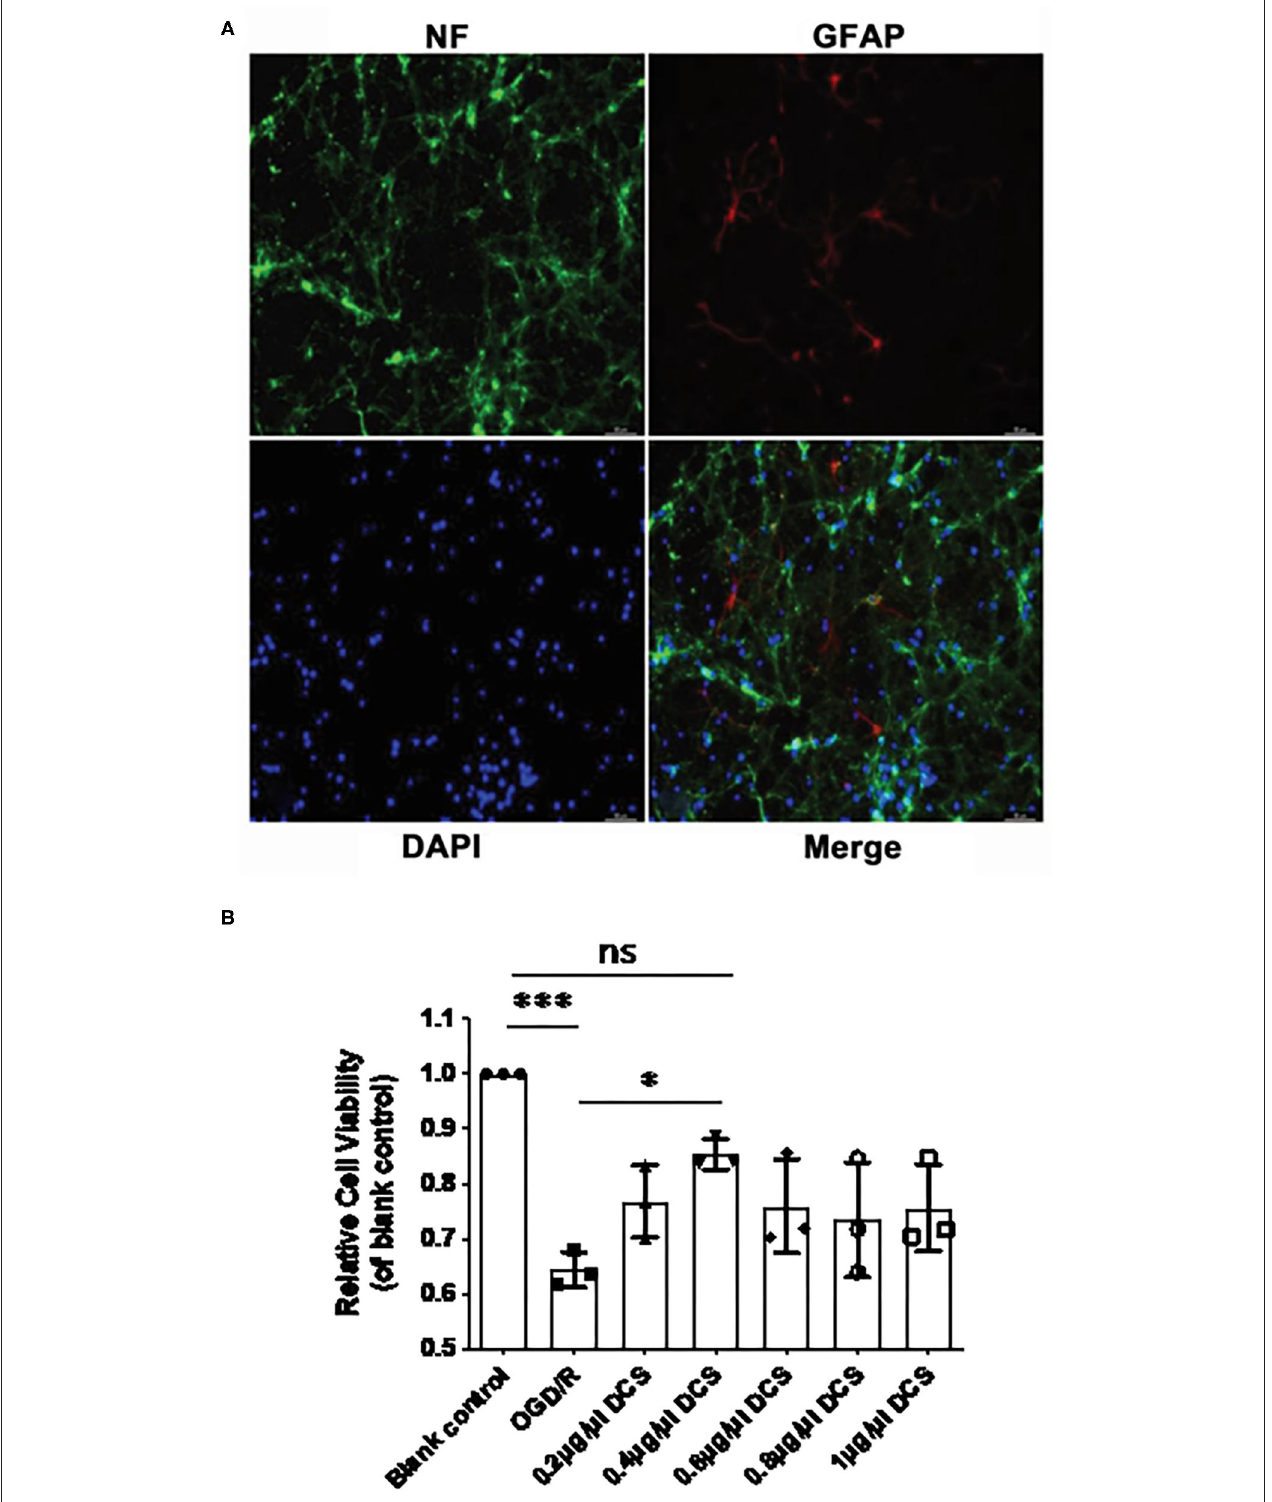
FIGURE 2 | Effect of DCS on the viability of cultured primary neurons exposed to oxygen-glucose deprivation/reperfusion (OGD/R). (A) Cultured primary neurons isolated from rat E18 embryos and immunostained for neurofilament (NF, expressed in neurons; green) and glial fibrillary acidic protein (GFAP, expressed in astrocytes; red). Nuclei were stained with 4 ′ ,6-diamidino-2-phenylindole (DAPI; blue). Neuronal cell purity exceeded 95%. (B) Cell viability determined by using Cell Counting Kit-8. Primary neurons were exposed to OGD/R and administered DCS for 4h at various concentrations (0, 0.2, 0.4, 0.6, 0.8, and 1 µ g/ µ l). Cells not exposed to OGD/R were used as a blank control group. Data shown as mean ± SEM, n = 3. * p < 0.05, *** p < 0.0005.